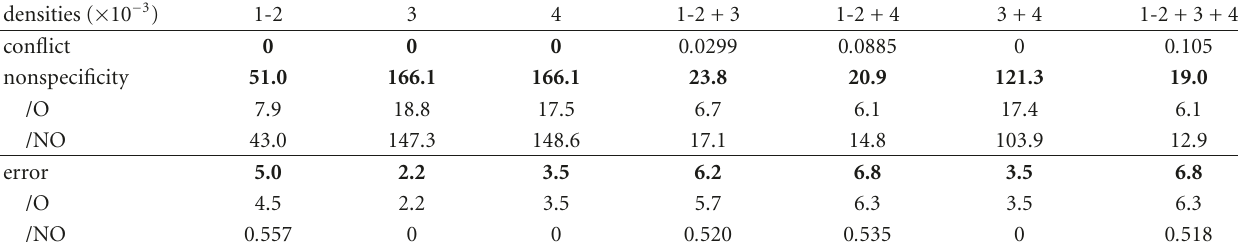
Table 2: Performances of the fusion in image 1, (1-2: mean standard deviation (segmentation), 3: skewness, 4: kurtosis). densities ( × 10 − 3